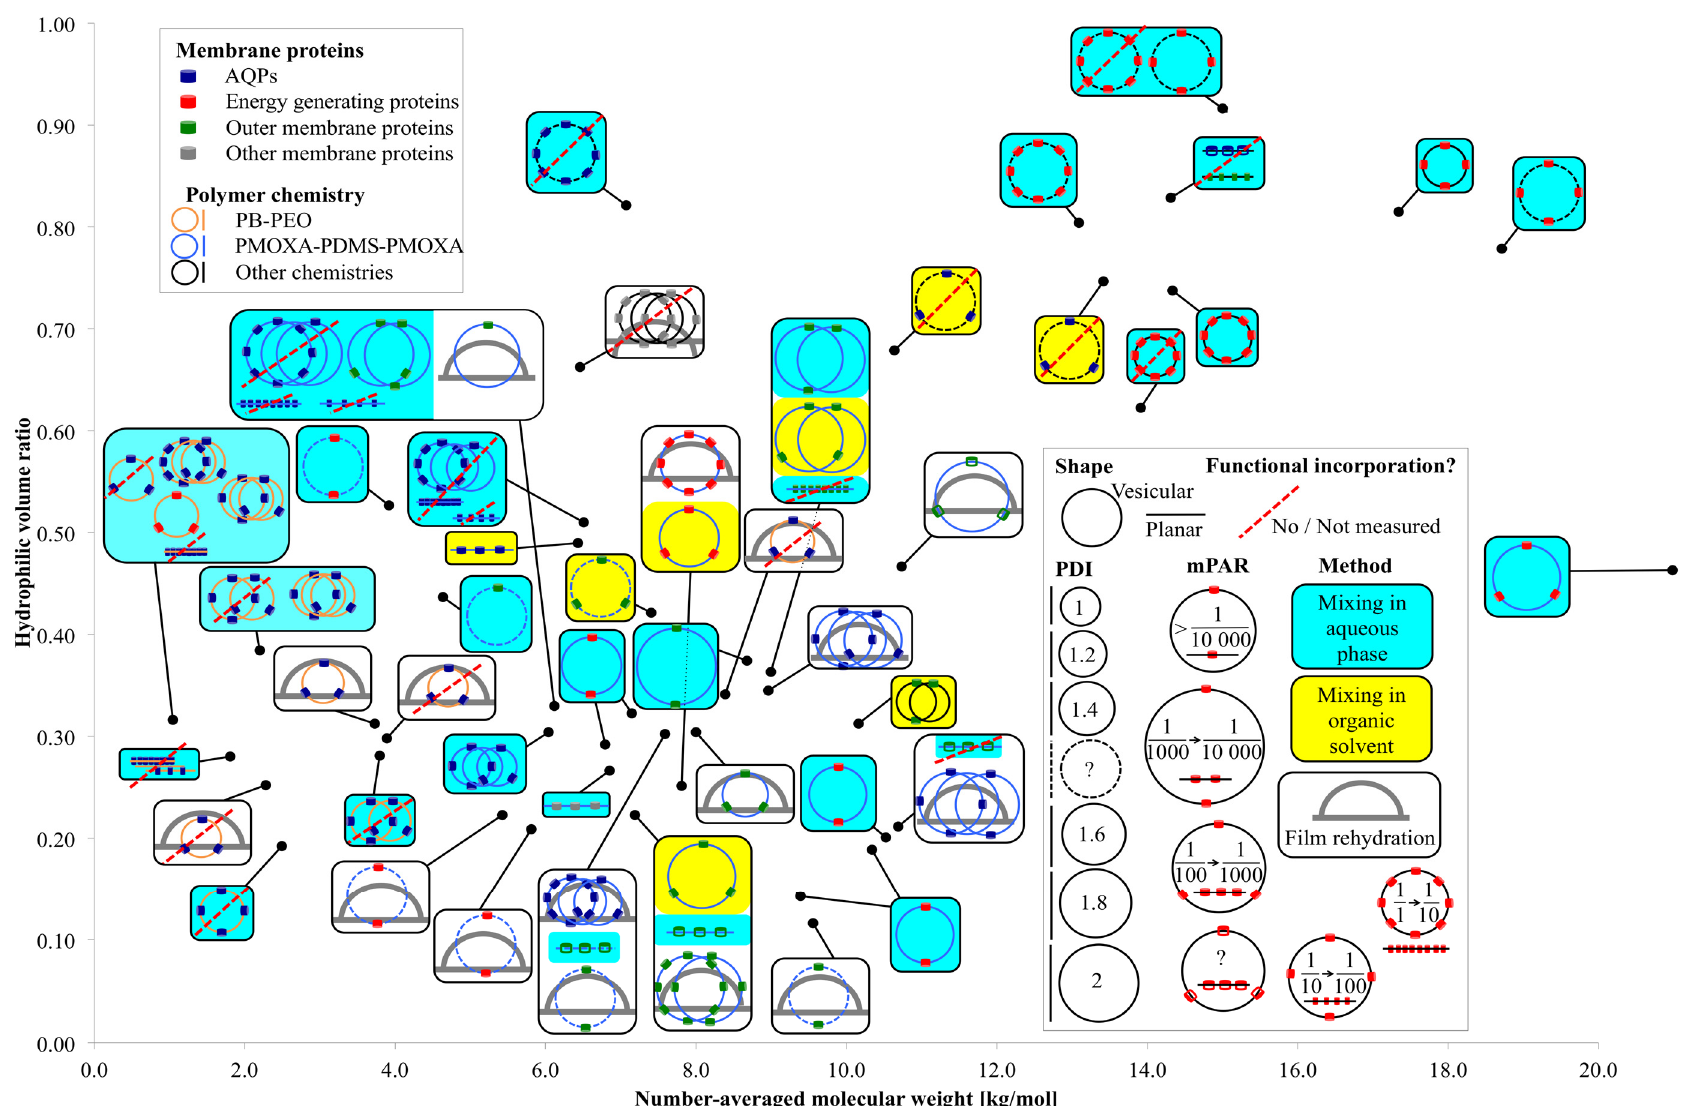
Figure 3. Overview of relevant parameters for membrane protein incorporation into amphiphilic block